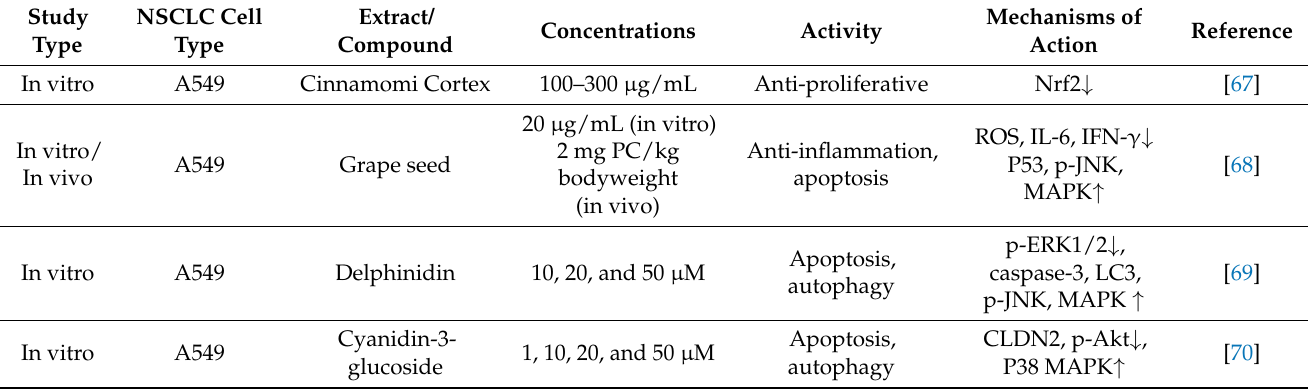
Table 3. The molecular mechanisms of PCs and ACNs in combination with radiotherapy/chemotherapy in nicotine-induced NSCLC